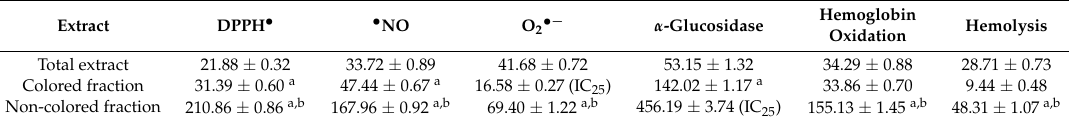
Table 3. IC 25 and IC 50 ( µ g/mL) values found in the antioxidant activity, α -glucosidase, hemoglobin oxidation, and hemolysis assays of Saco sweet cherry extracts.